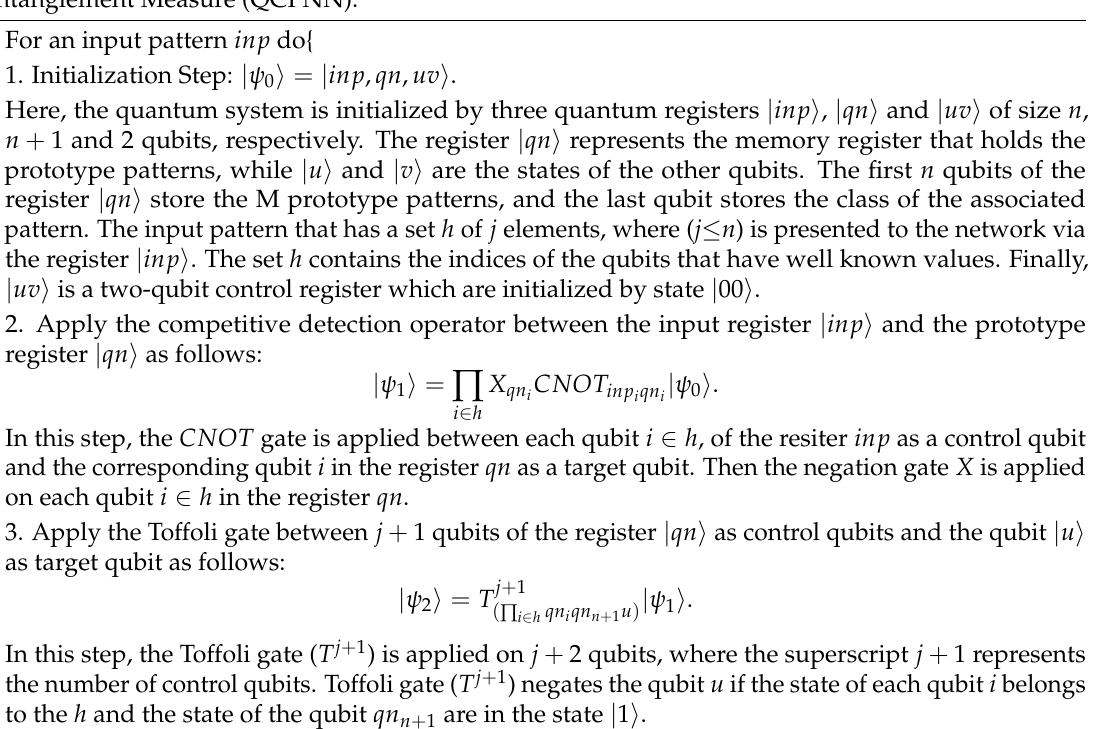
Algorithm 1 The proposed Quantum Classification Algorithm based on Competitive Learning and Entanglement Measure